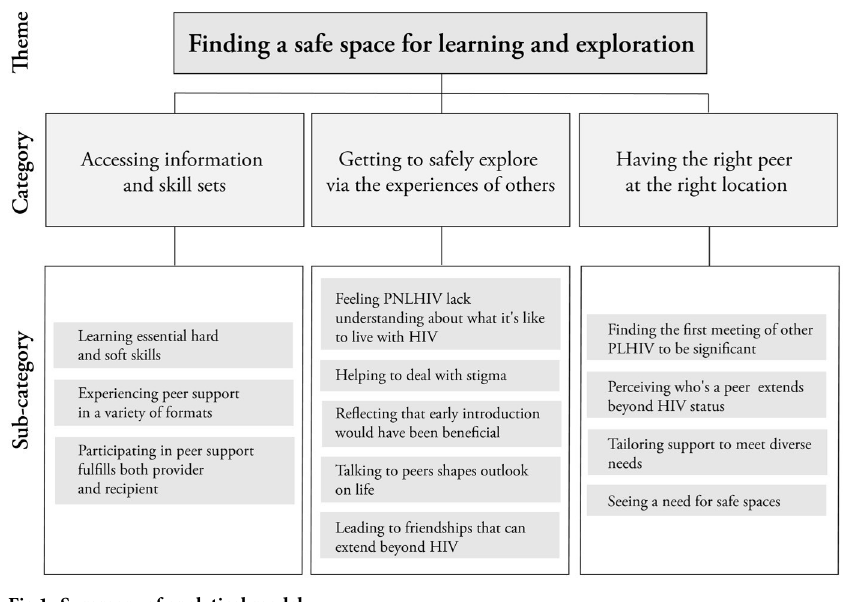
Fig 1. Summary of analytical